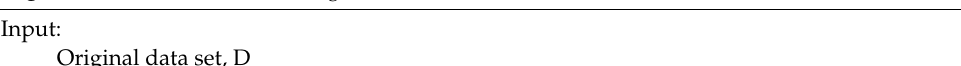
Algorithm 2: Feature selection algorithm (RFP)